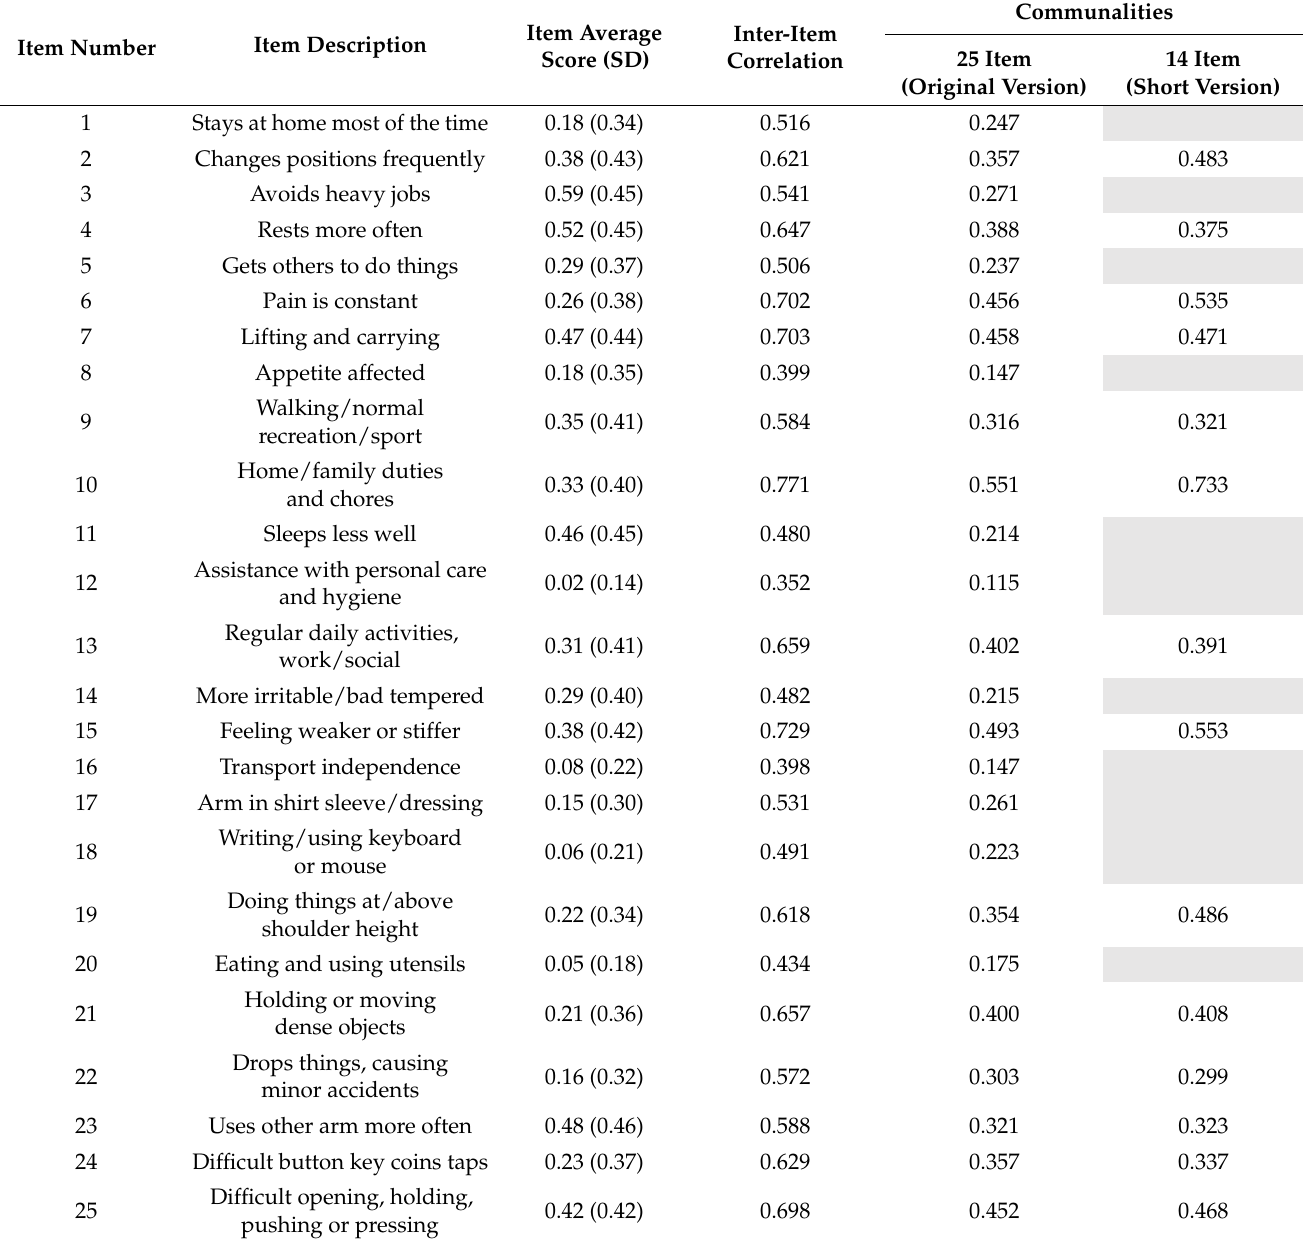
Table 2. Twenty-five-item average score, correlation and communalities from ULFI-Sp in BCS and fourteen-item short version